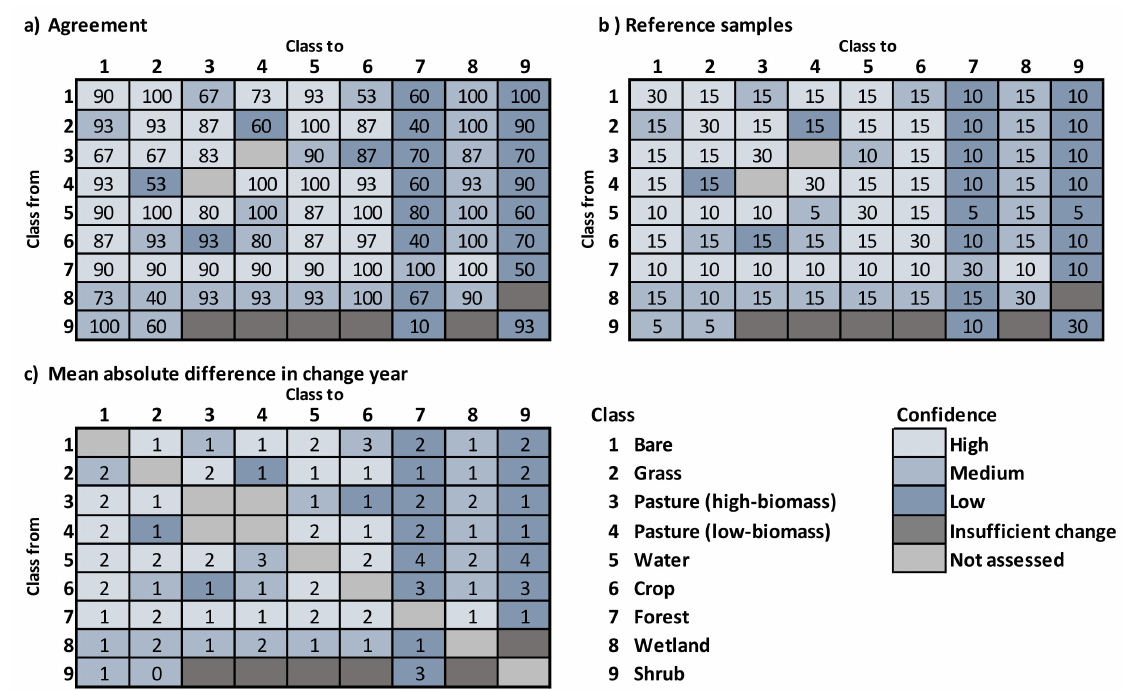
Figure 5. Change assessment by change class ( a ) percent agreement with reference samples, ( b ) number of reference samples, ( c ) mean absolute difference in the change